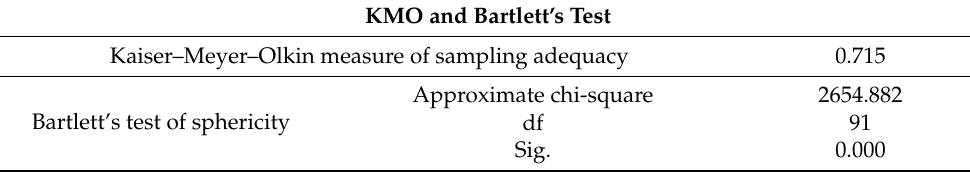
Table 2. KMO and Bartlett’s